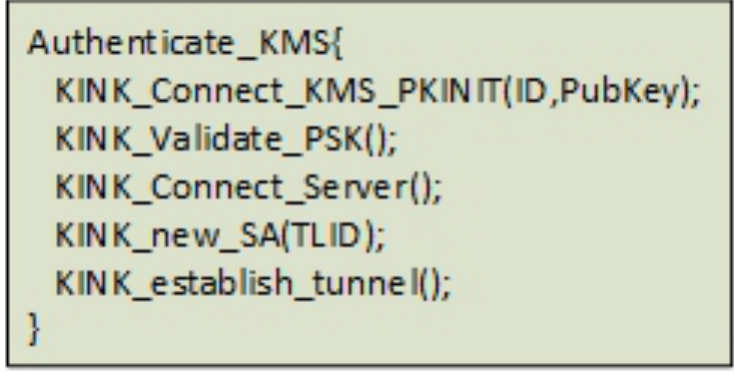
Figure 23. The Kerberized Internet Negotiation of Keys authentication protocol